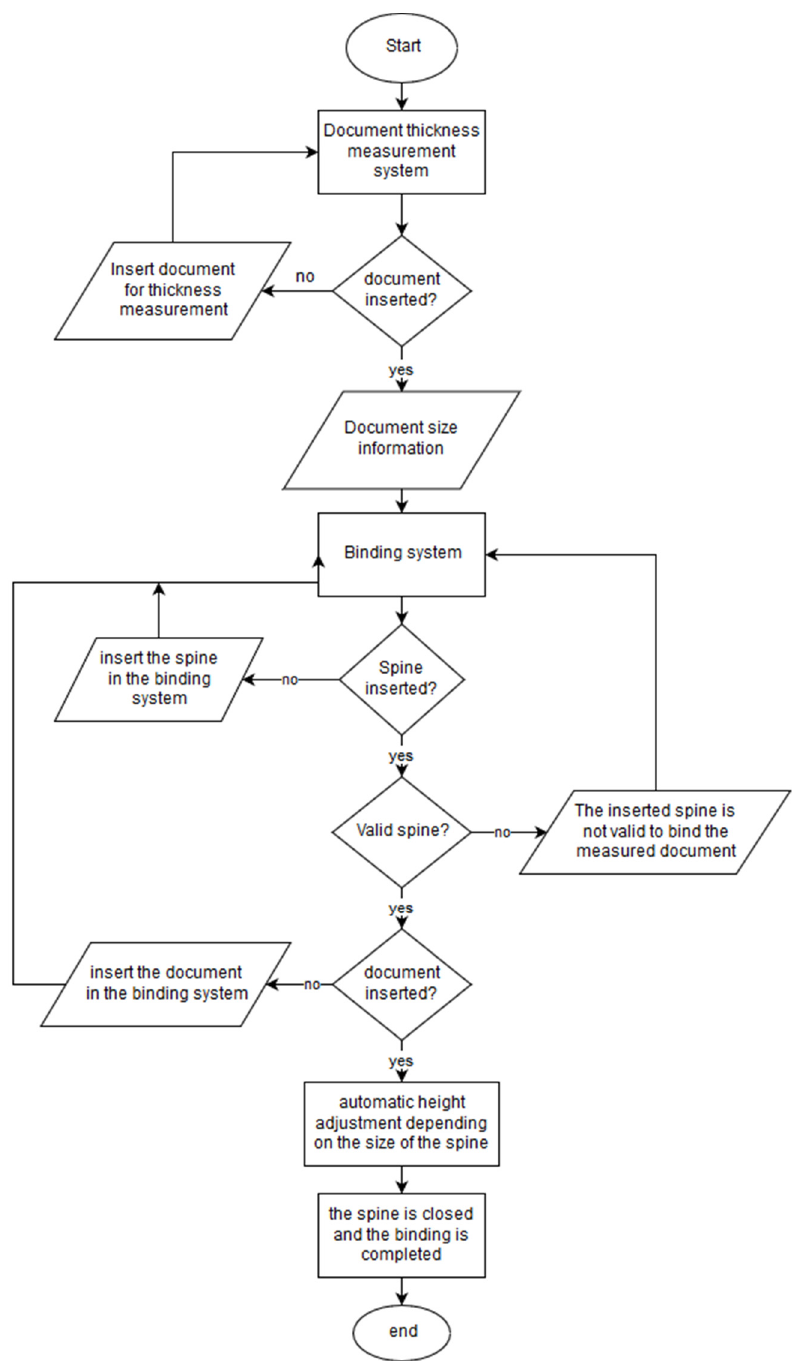
Figure 31. Block diagram for the binding of a document. The binding block diagram begins with the document thickness measurement.